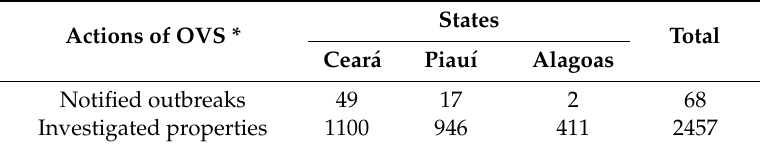
Table 3. Reports’ summary of the O ffi cial Veterinary Service during the outbreaks of classical swine fever in 2018 and 2019, by